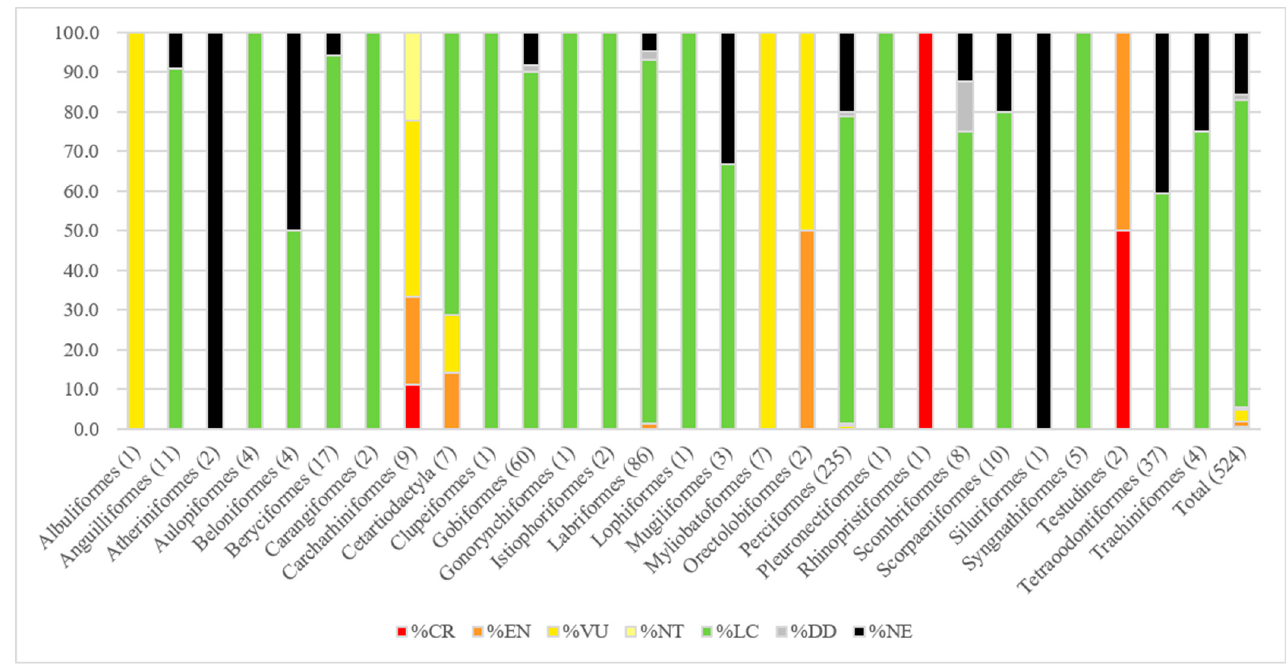
Figure 2. Percentage of species in different Red List categories, arranged taxonomically, by order, with number of species in each order included in